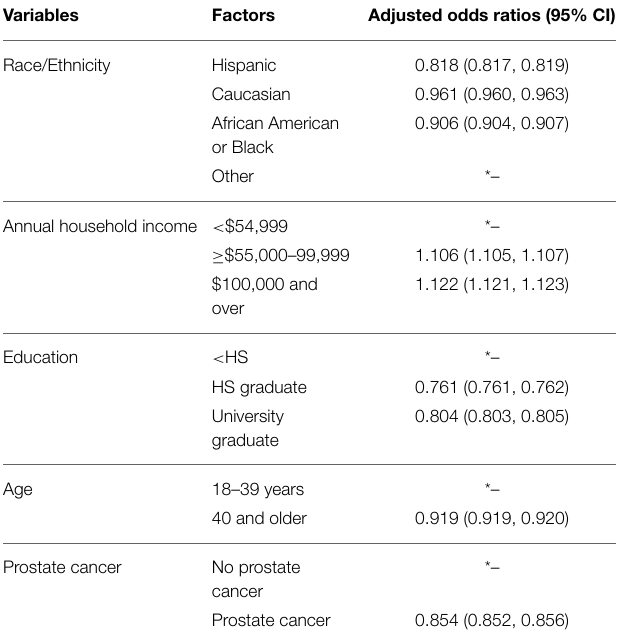
TABLE 3 | Logistic regression with high grade ( > 3mg/ml) inflammation C-reactive protein values as the dependent variable 2008–2009 NHANES